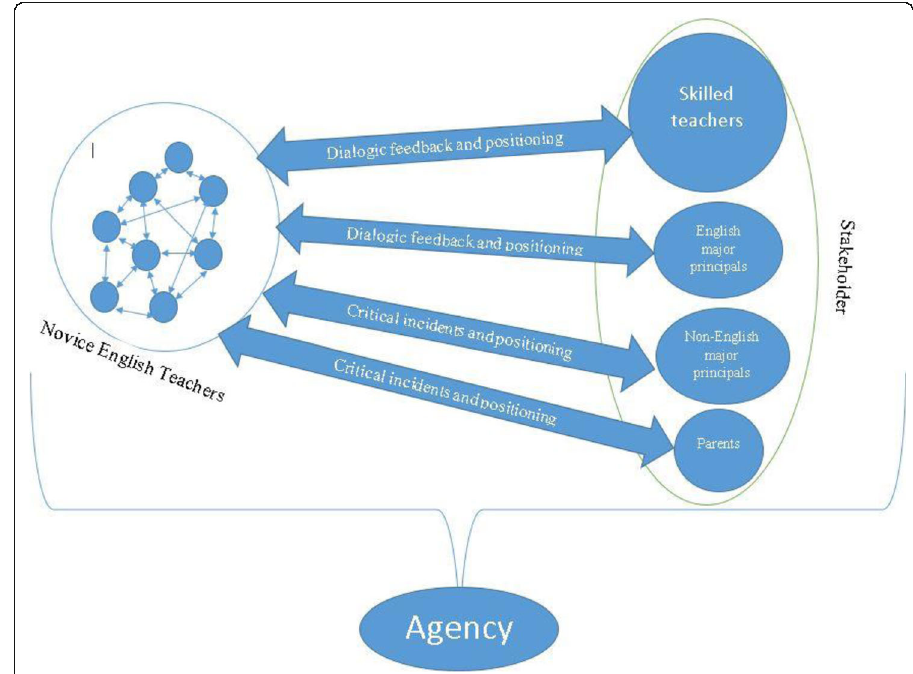
Fig. 1 The model of teacher agency among the novice